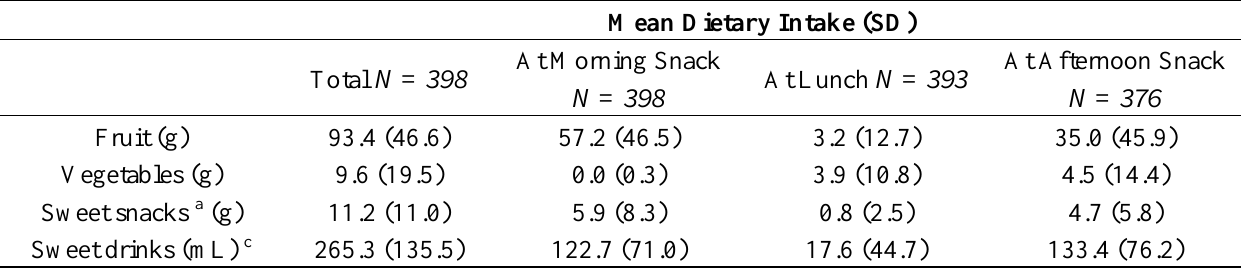
Table 2. Average dietary intake by toddlers at